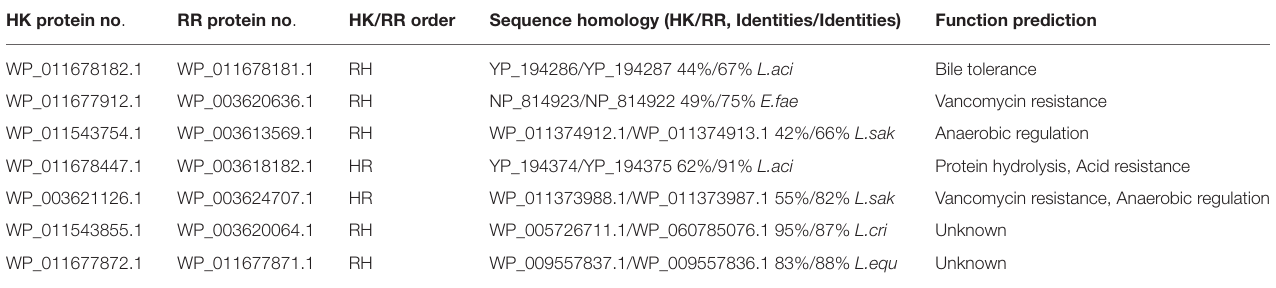
TABLE 2 | Functional prediction of L. bulgaricus BAA-365 TCS system. HK protein no . RR protein no . HK/RR order Sequence homology (HK/RR, Identities/Identities) Function prediction